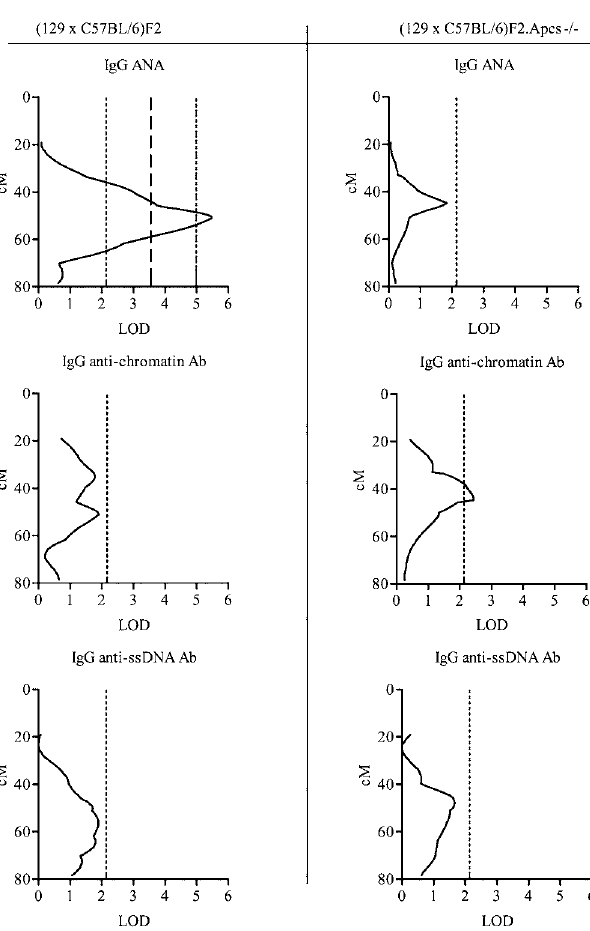
Figure 7. Interval Mapping Scans Showing QTL on Chromosome 3 with ANA, Anti-Chromatin, and Anti-ssDNA Abs See Table 3 for additional details. Centimorgan positions were deduced by interval mapping, anchoring marker locations to data from http://www.informatics.jax.org. Dotted lines indicate the thresh- old over which linkage was considered suggestive, the dashed line indicate the threshold over which linkage was considered significant, and dotted/dashed lines indicate highly significant linkage, as defined in Materials and Methods. DOI: